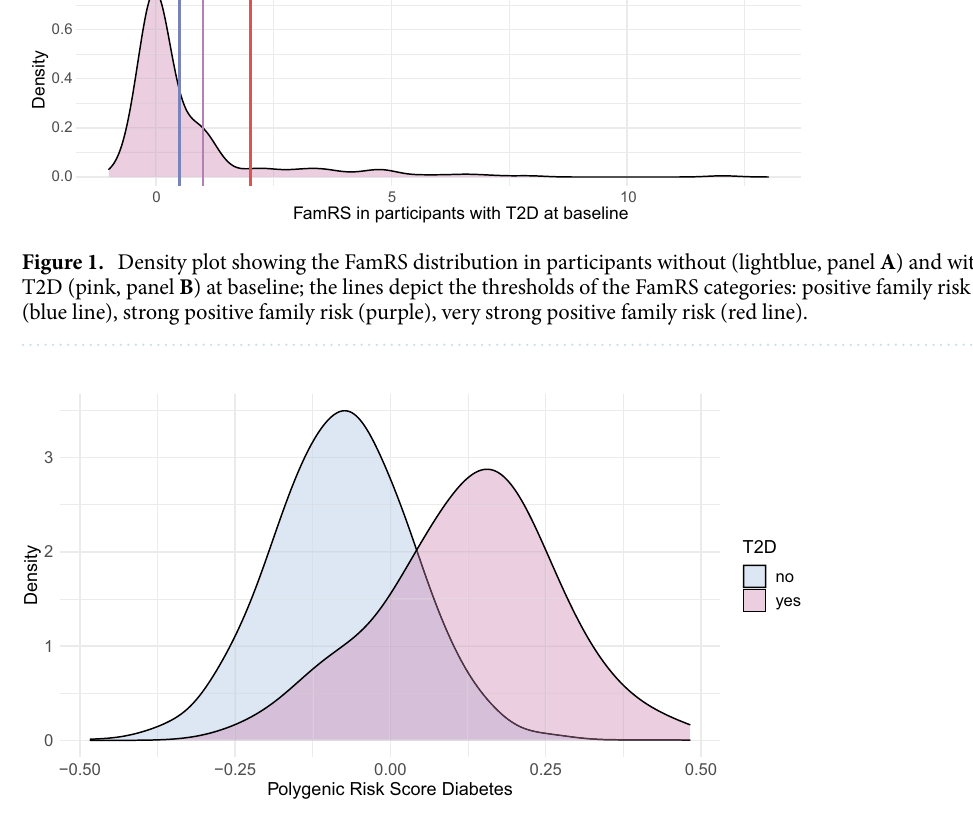
Figure 2. Density plot showing the PGS distribution in participants without (lightblue) and with T2D (pink) at baseline.